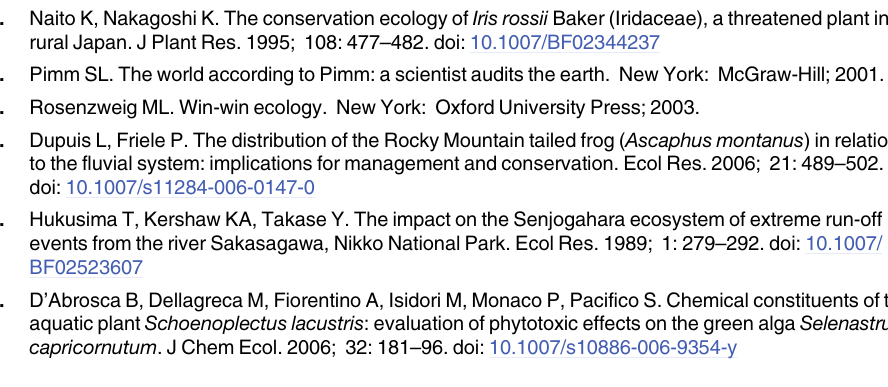
S1 Table. Temporal changes in the number of newly settled individuals and the total num- ber of individuals. S2 Table. The life span, settlement dates, and wash-out dates of settled gemmae. S3 Table. The number of culms of each individual on four measurement days. Dates I – IV are defined in the text. S4 Table. Temporal changes in the number of culms of 38 individuals. The numeral "zero" indicates that the plant was washed out. Dates I – IV are defined in the